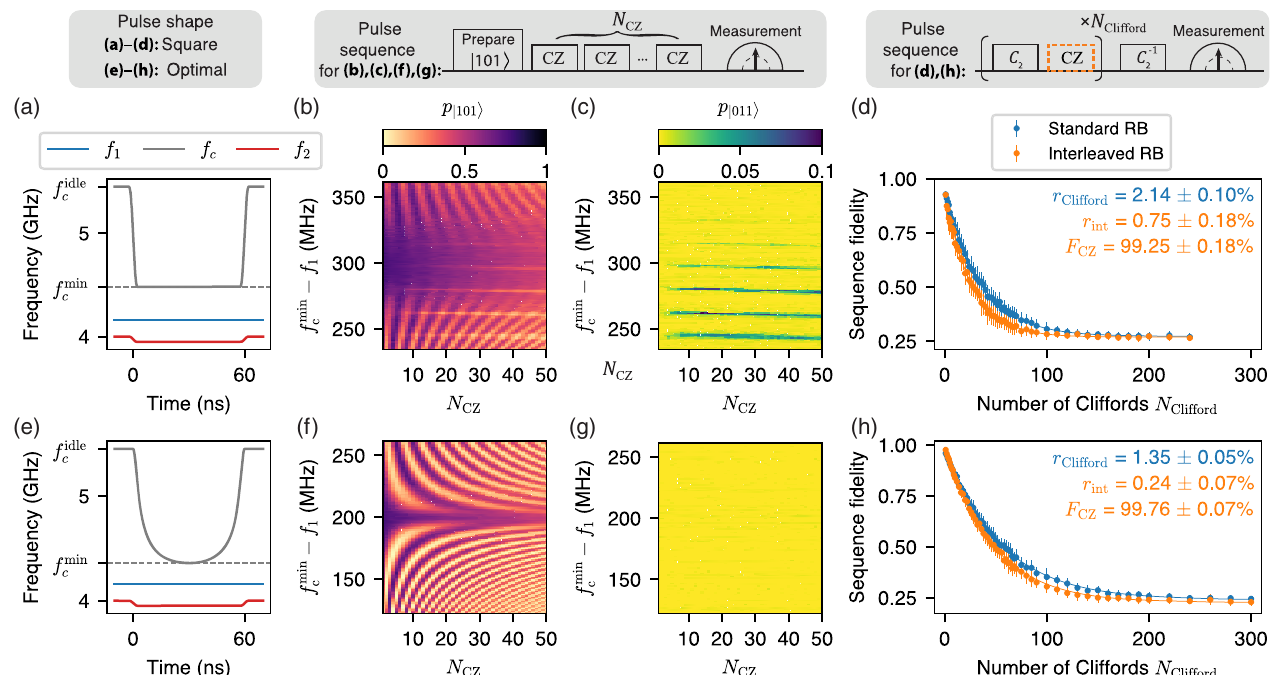
FIG. 4. Suppressing leakage to the coupler by optimizing the coupler control. (a),(e) Square-shaped and Slepian-based optimal control waveforms for 60-ns-long CZ gates, respectively. (b),(f) State population of j 101 i after applying repeated CZ gates versus the coupler − f 011 i after applying repeated CZ gates. The pulse amplitude ( f min 1 ) and the number of CZ gates N CZ . (c),(g) Leakage population to j c square-shaped pulse shows periodic leakage to j 011 i , which is suppressed down to the background noise limit by optimizing the pulse shape. (d),(h) Interleaved randomized benchmarking (RB) results of the CZ gates. The pulse sequence is illustrated at the top; we apply N random two-qubit Clifford gates ( C 2 ) and the recovery Clifford gate C − 1 2 , which makes the total sequence equal to the identity Clifford . To ensure operation. Errors bars represent (cid:1) 1 standard deviations. We measure 30 random sequences for each sequence length N Clifford accurate uncertainties of the error rates ( r and r ), we perform a weighted least-squares fit using the inverse of variance as the Clifford int